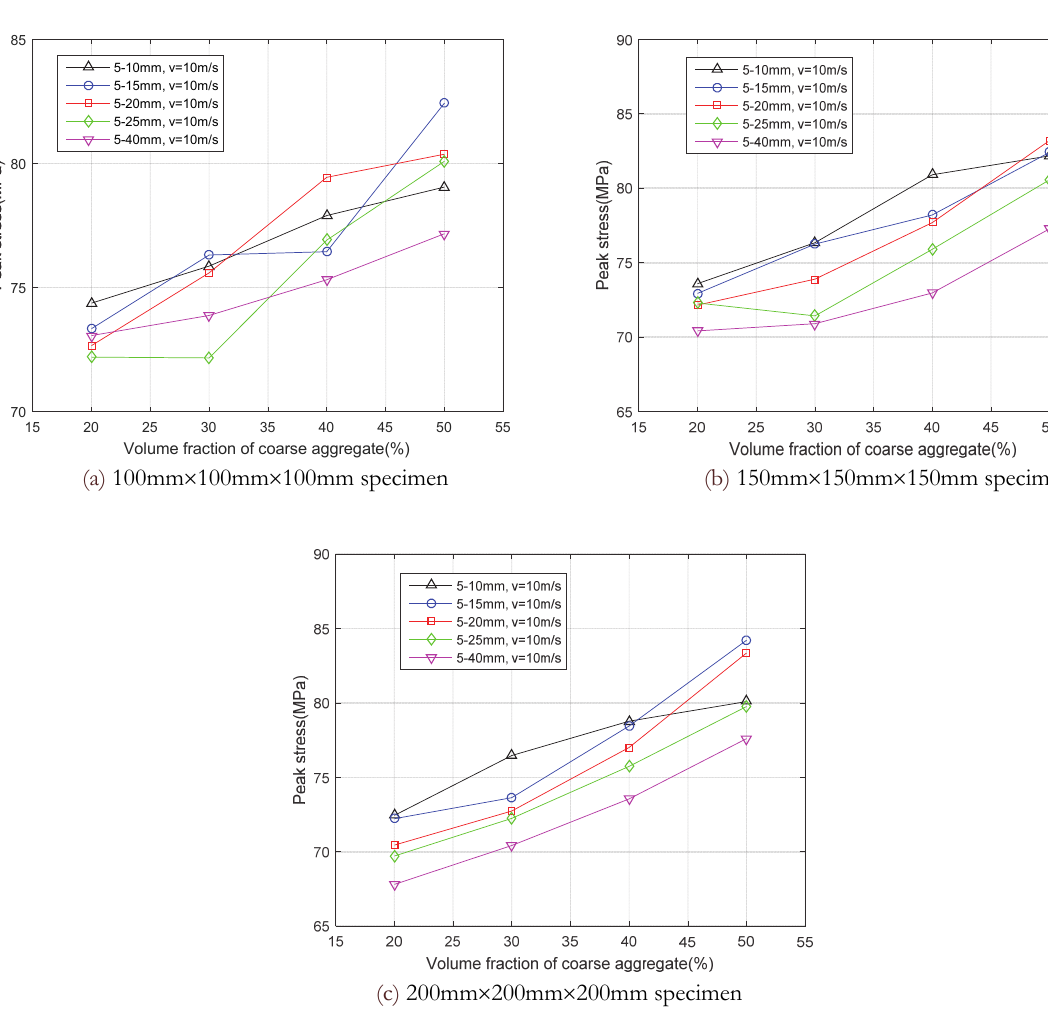
Figure 6: Relationship between aggregate volume content and peak stress of